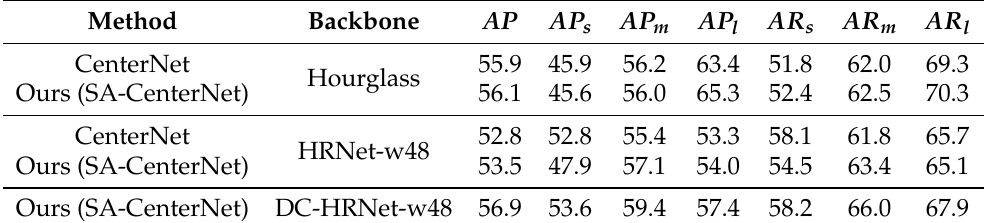
Table 8. Ablation study results for different backbone networks on